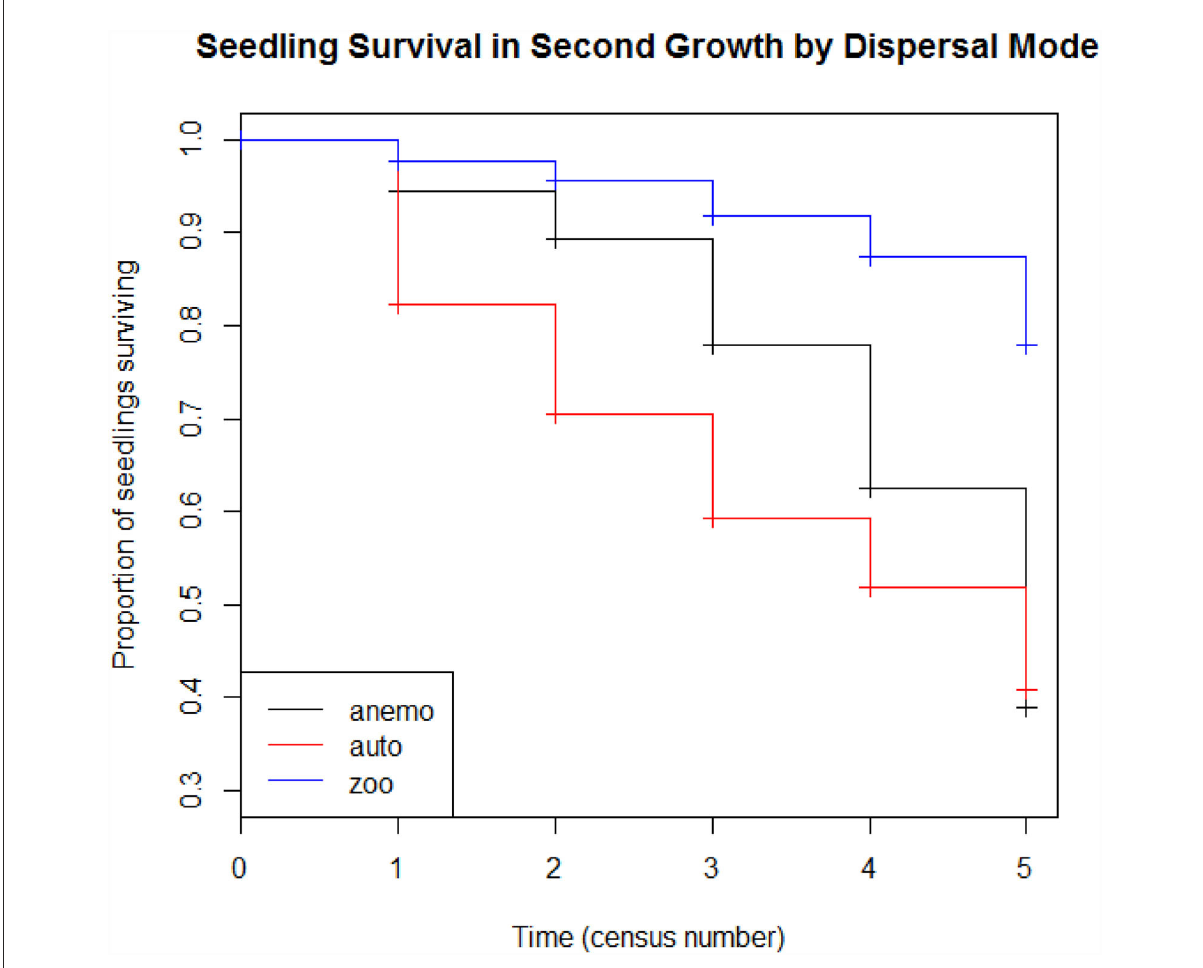
FIGURE8 Seedling survival model for anemochorous, autochorous, and zoochorous seedlings in four second-growth plots during six census